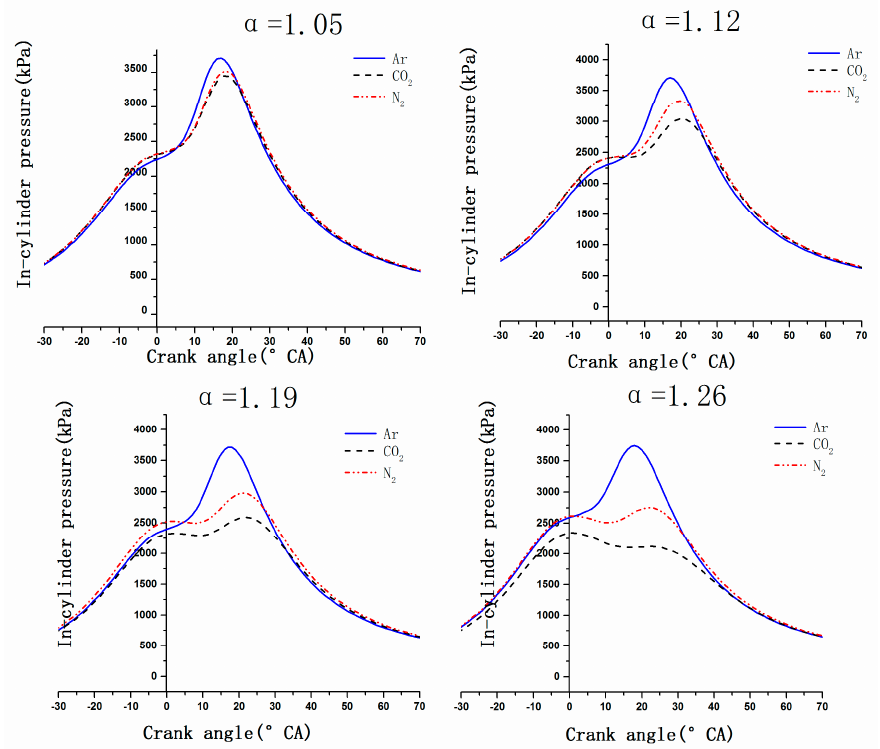
Figure 9. Variation in the in-cylinder pressure vs. crank angle with the DF of CO 2 , N 2 and Ar.